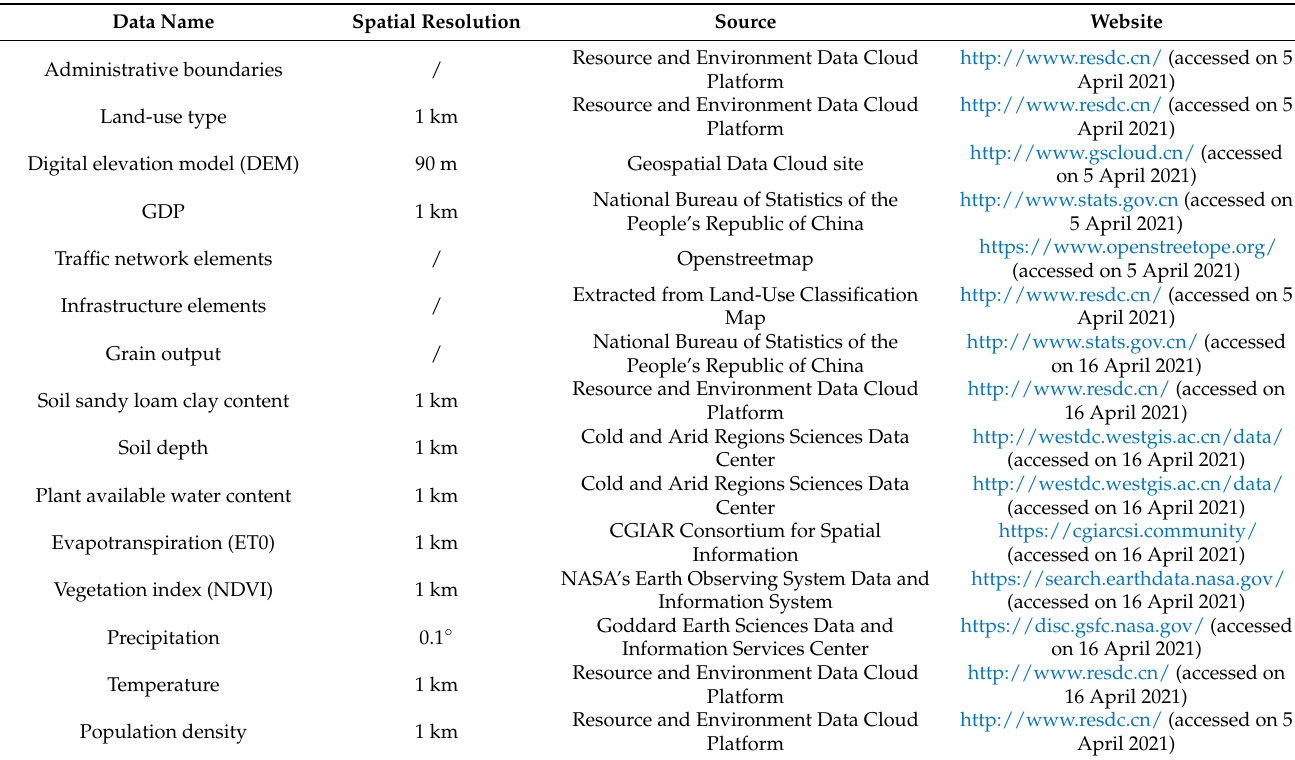
Table 1. Data information table.